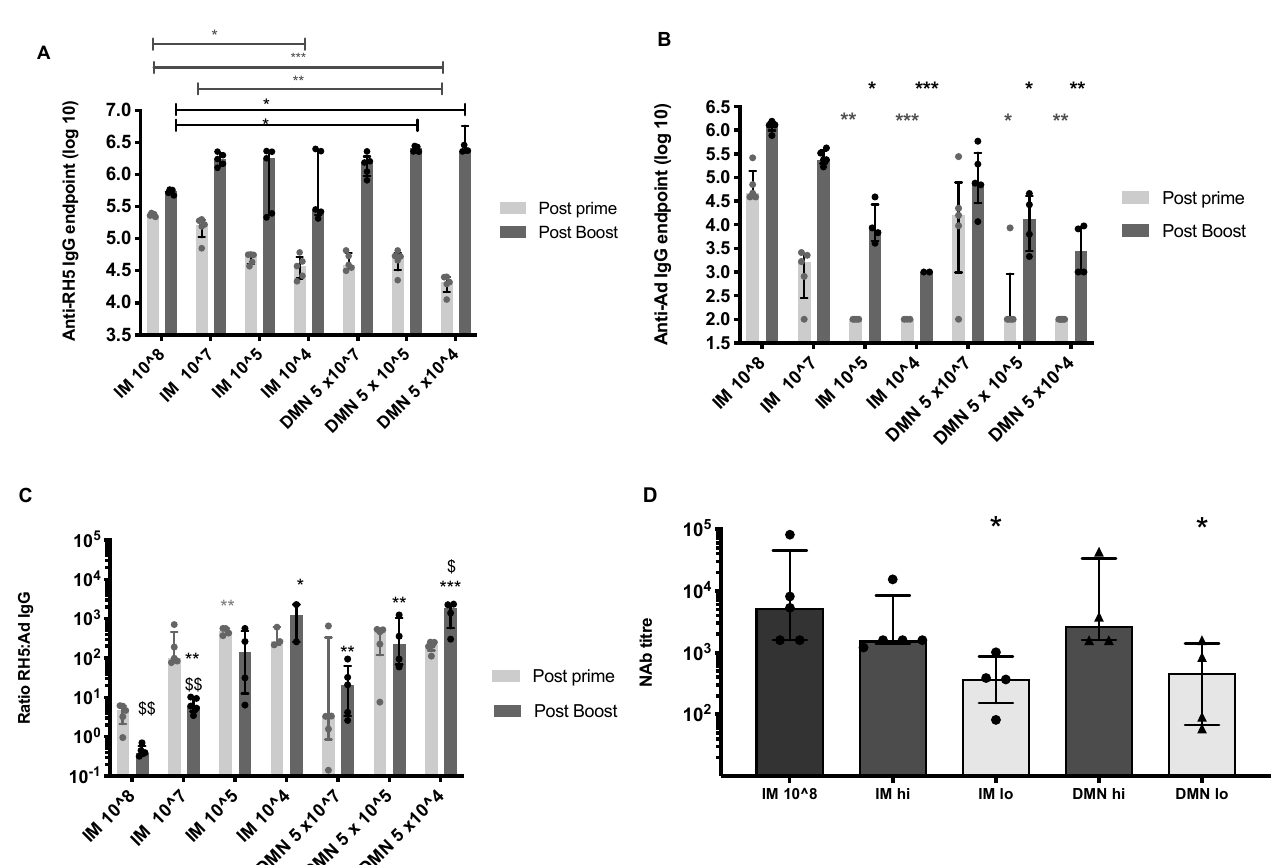
Figure 2. Effect of vaccine dose and route on the induction of IgG antibodies to PfRH5 antigen and to the adenovirus vector. Female Balb/c mice ( n = 5 per group) were immunized on day 0 with AdHu5–PfRH5 by the IM route or using DMN patches. The following doses were administered by IM (from left to right); 1 × 10 8 ifu, 1 × 10 7 ifu, 1 × 10 5 ifu, or 1 × 10 4 ifu to each mouse. Alternatively, 5 × 10 7 ifu, 5 × 10 5 ifu, or 5 × 10 4 ifu were administered in two patches to each mouse; one patch per ear. Serum IgG responses were assessed 8 weeks after the priming immunization (light grey bars). All mice were boosted on day 54 with 1 × 10 8 ifu AdHu5–PfRH5 by the IM route and post-boost IgG responses were assessed 2 weeks after this boost (dark grey bars). ( A ) IgG responses to the encoded antigen PfRH5. * p < 0.05, ** p < 0.01, *** p < 0.001 by one-way ANOVA, Kruskal–Wallis test with Dunn’s multiple comparison. Light grey lines and stars indicate significant differences across post-prime samples, dark grey lines indicate significant differences across post-boost samples. ( B ) IgG responses to the AdHu5 vector. * p < 0.05, ** p < 0.01, *** p < 0.001 compared to control, IM 1 × 10 8 ifu. ( C ) The ratio of anti-PfRH5 IgG titre to anti-vector IgG in each animal. * p < 0.05, ** p < 0.01, *** p < 0.001 compared to control, IM 1 × 10 8 ifu. $ p < 0.05, $$ p < 0.01 of post-prime compared to post-boost within the same group. ( D ) Neutralizing antibody responses to AdHu5 vector 2 weeks after boosting. “IM lo” and “DMN lo” refers to priming mice with a low dose of 1–5 × 10 4 ifu by IM injection or DMN patch, whereas “IM hi” and “DMN hi” refer to a high dose of 1–5 × 10 7 ifu by IM or DMN patch-based administration in the prime * p < 0.05, compared to control, IM 1 × 10 8 ifu. Bars represent median, error bars represent interquartile range, dots represent individual samples.